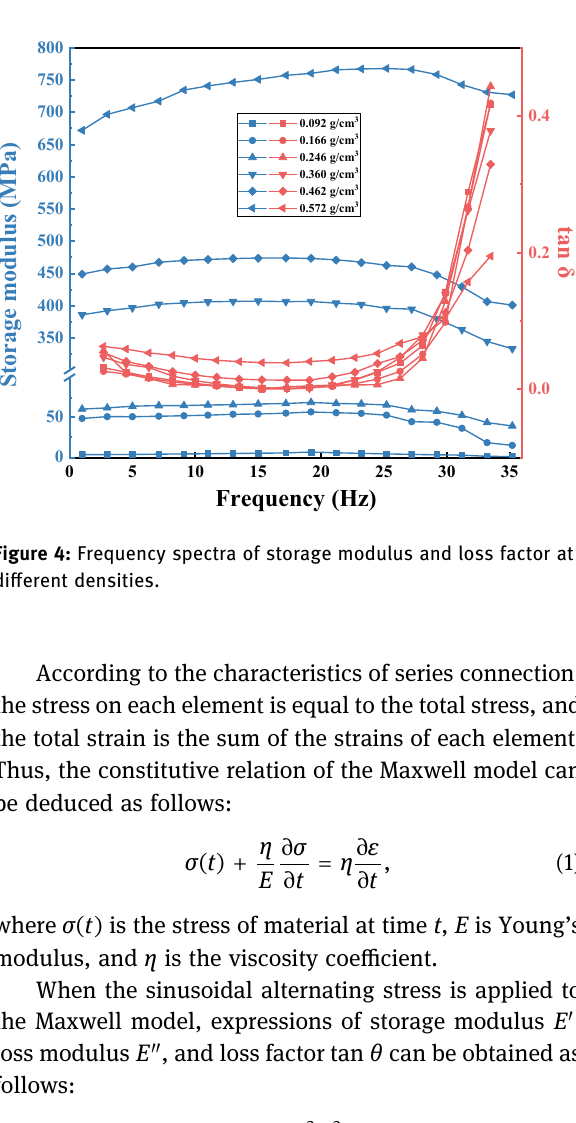
Figure 3. As can be seen from Figure 4, at room temperature, the storage modulus of polymer material with each density increases at fi rst and then decreases with the increase of frequency, while the loss factor fi rst decreases slightly and then increases greatly with the increase of frequency.